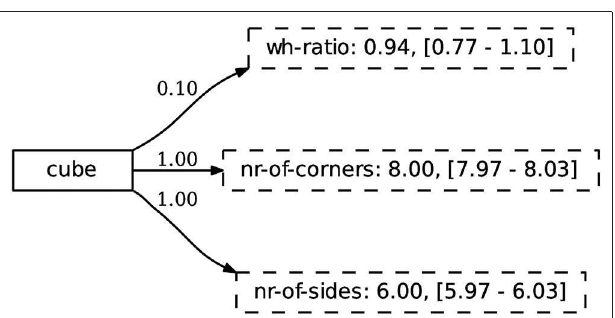
FIGURE 4 | The concept CUBE is linked to a weighted set of attributes. The weight represents the certainty of an attribute belonging to the concept. Each attribute is modeled as a normal distribution that keeps track of its prototypical value (i.e., the mean) and the standard deviation. The values between square brackets denote two standard deviations from the mean. These are not used in similarity calculations directly, but give an indication of the observed range of prototypical